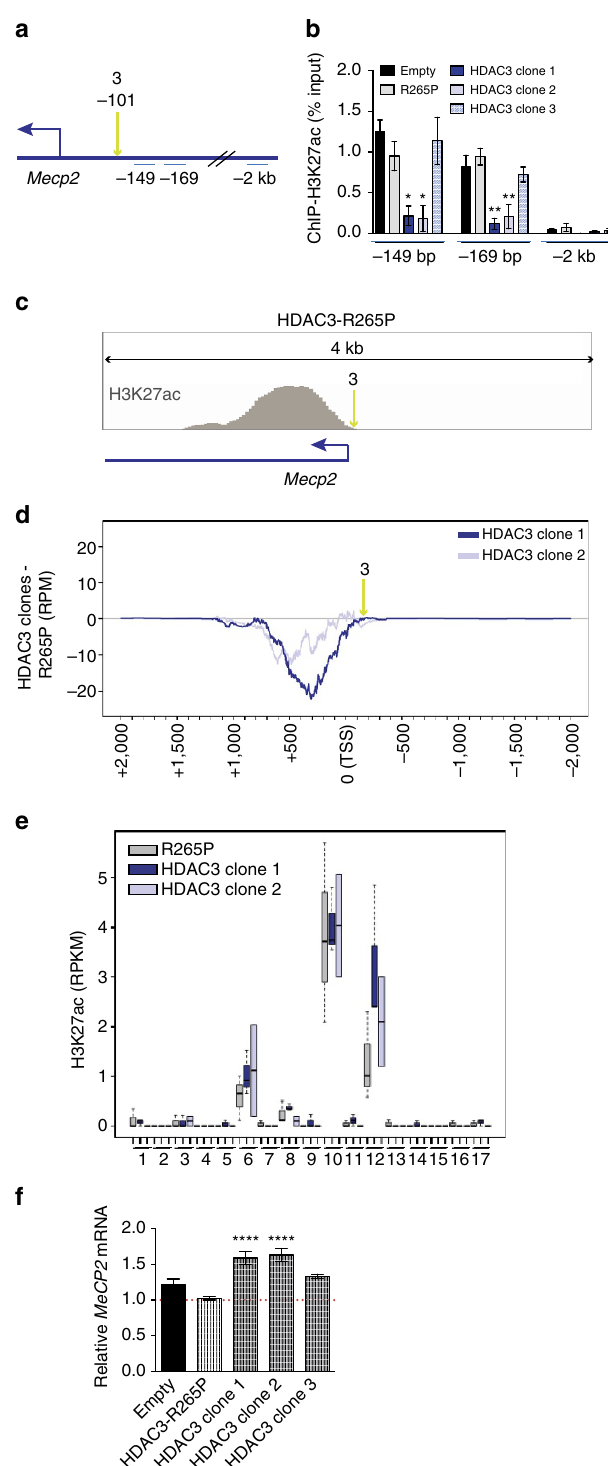
Figure 4 | Assessing gRNA dosage and dCas9-HDAC3 range of activity at the Mecp2 locus. ( a ) The Mecp2 promoter locus is schematically depicted with the approximate locations of gRNA-3 and the ChIP-qPCR amplicon regions (in blue). ( b ) H3K27ac ChIP-qPCR enrichment (relative to dCas9-HDAC3 R265P ) at regions in the Mecp2 promoter depicted in Fig. 2c. One-way ANOVA with Dunnett post-test; * P o 0.05; ** P o 0.01; n ¼ 4 biological replicates; error bars, s.e.m. ( c ) H3K27ac enrichment at a genomic locus encompassing a 4kb region around the Mecp2 TSS in dCas9-HDAC3 R265P clonal cells. Green arrow indicates the position of gRNA-3. ( d ) Genomic region centred on the Mecp2 TSS (0 ¼ TSS) depicting the subtraction of the normalized H3K27ac uniquely mapped reads (RPM) in each dCas9-HDAC3 clone (clone 1: n ¼ 3 biological replicates; clone 2: n ¼ 2 biological replicates) from the normalized H3K27ac reads (RPM ¼ reads per million) in the dCas9-HDAC3 R265P clone ( n ¼ 3 biological replicates). ( e ) H3K27ac RPKM values for the dCas9-HDAC3 R265P clone (R265P), dCas9-HDAC3 clone 1 (HDAC3 clone 1) and dCas9-HDAC3 clone 2 (HDAC3 clone 2) at 17 potential off-target sites for Mecp2 gRNA-3 in the genome. ( f ) Relative mRNA expression of Mecp2 determined by RT–PCR by the indicated dCas9-HDAC3 clones co-expressing Mecp2 gRNA-3 (relative to dCas9-HDAC3 R265P also co-expressing Mecp2 gRNA-3) One-way ANOVA with Dunnett post-test; **** P o 0.0001; n ¼ 7 biological replicates; error bars,